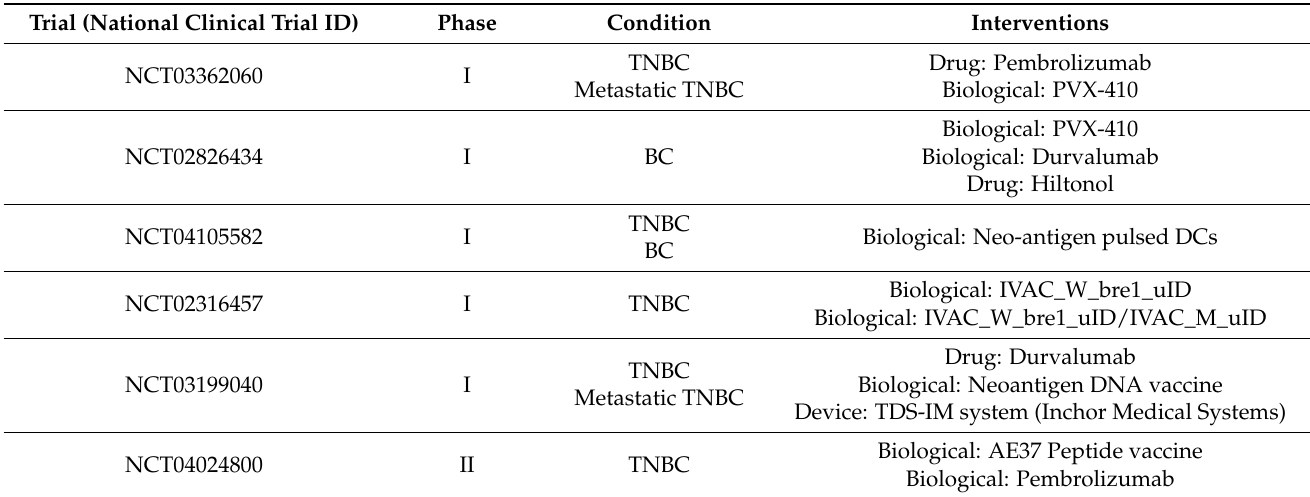
Table 3. List of active and ongoing clinical trials investigating cancer vaccines for TNBC. Trial (National Clinical Trial